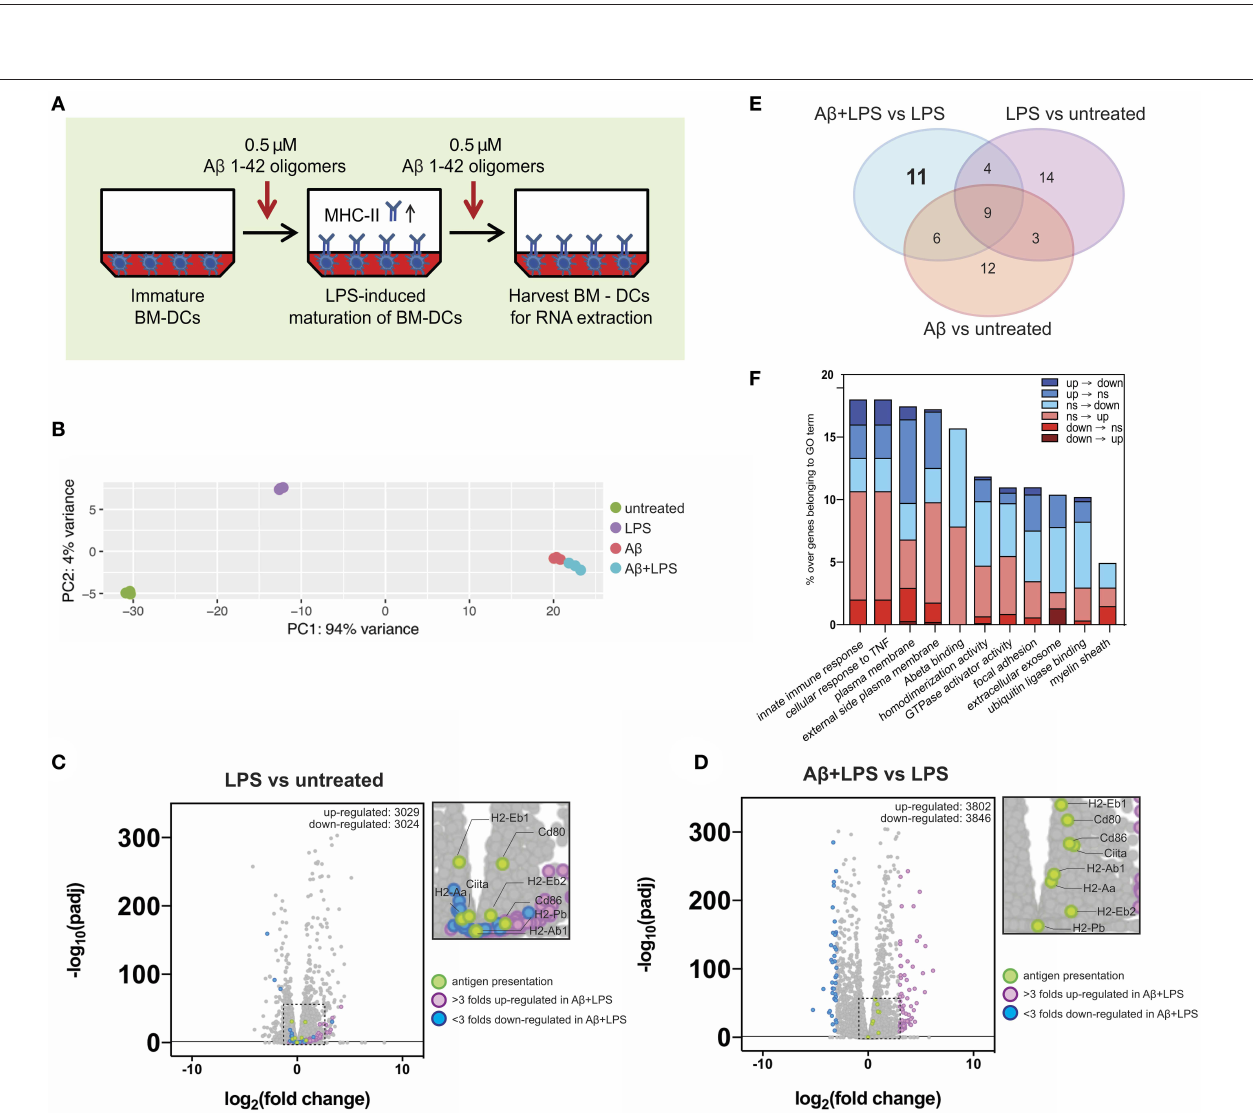
FIGURE 5 | intensity = MedianFI) is detectable after applying A β 1-42 oligomers to in vitro antigen presentation assays. (E,G) Analysis of surface co-stimulatory factor CD80/CD86 expression shows that A β 1-42 oligomers (but not scr peptide) increase CD80 + /CD86 + BM-DC frequencies. (F,H) In comparison with LPS-matured BM-DCs, surface expression of CD80/CD86 per cell (measured by MedianFI) is further increased after applying A β 1-42 oligomers. Representative results of at least 3 independent experiments are shown in each graph; n ≥ 2 per treatment condition in each experiment. (Data are shown as mean ± SD, ** p < 0.01, *** p < 0.001, **** p < 0.0001, n.s. = non-significant, one-way ANOVA).